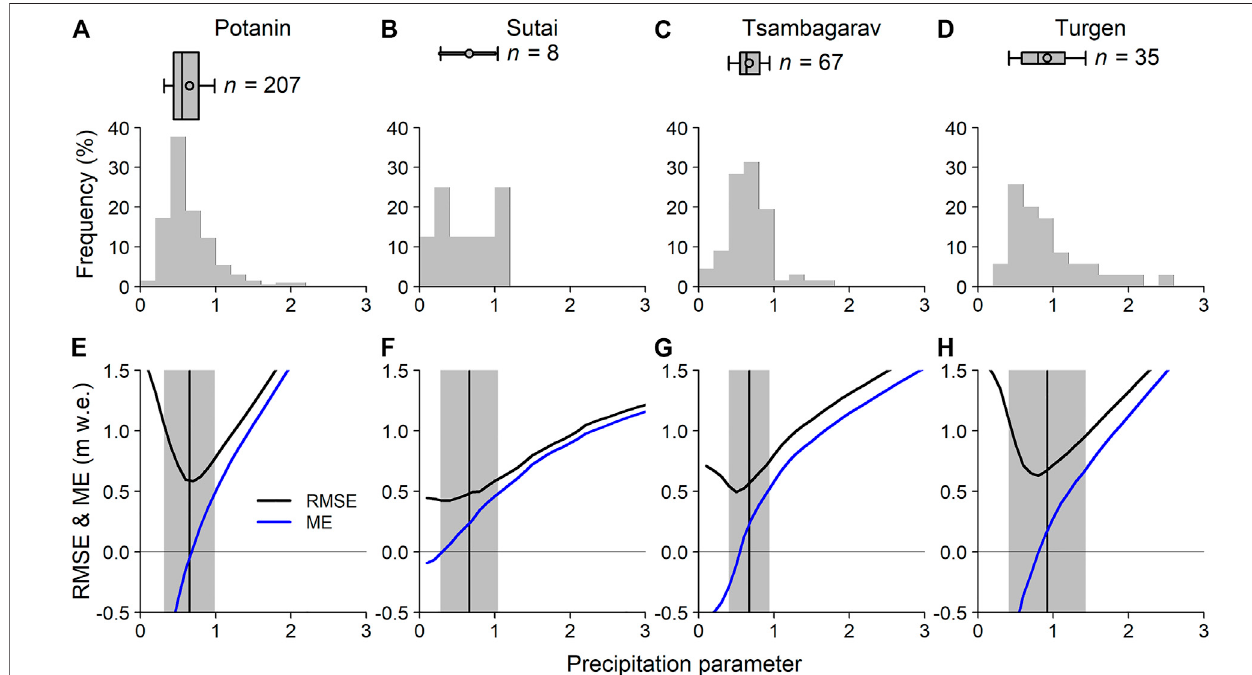
FIGURE 2 | Histogram and box plot (upper panels), and root mean square error (RMSE) and mean error (ME) (lower panels) of the precipitation parameter for Potanin (A,E) ,Sutai (B,F) ,Tsambagarav (C,G) andTurgen (D,H) glaciers.Thehorizontalboxwidth,line,circleandwhiskersdenotetheinterquartile,median,meanand standard deviations, respectively. The vertical width of the box indicates the number of mass balance measurements used to determine the precipitation parameter ( n ). The vertical line and grey shaded region in the lower panels denote the mean and standard deviations of the precipitation parameter,